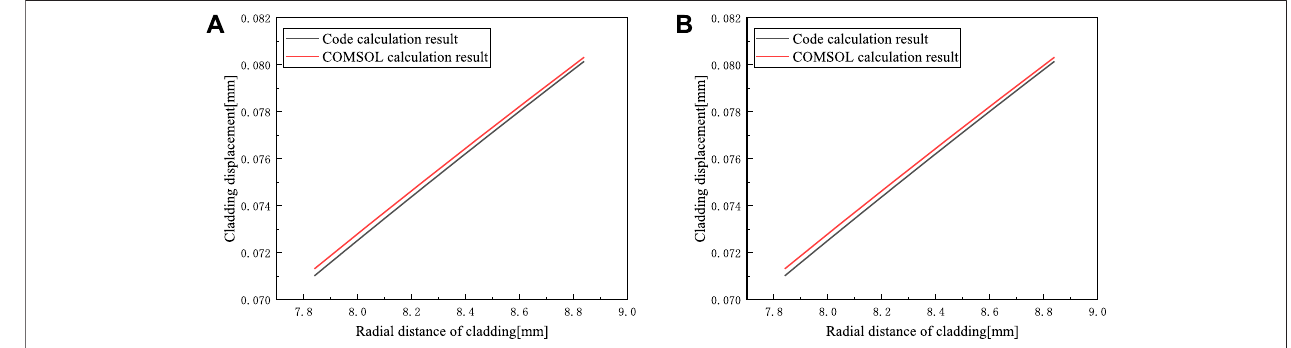
FIGURE 9 | Comparison of displacement results of the cladding, (A) at 1 day, (B) at 1,000 days